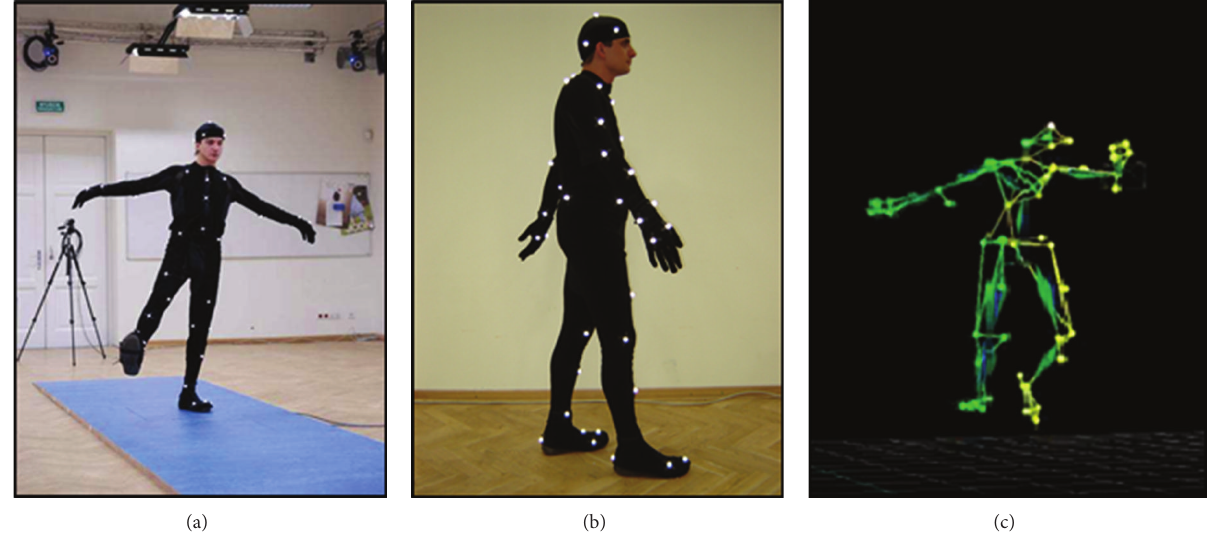
Figure 18: Motion capture recording in the Human Motion Laboratory.